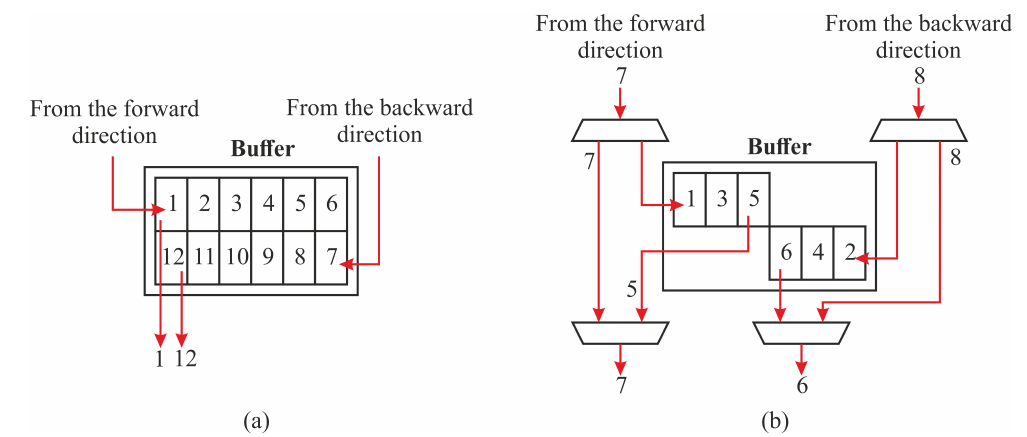
Figure 25. Writing and reading patterns: ( a ) the conventional approach on general-purpose platforms, ( b ) the proposed approach that halves the memory and time. The numbers indicate the writing order assuming, e.g., 6 columns per